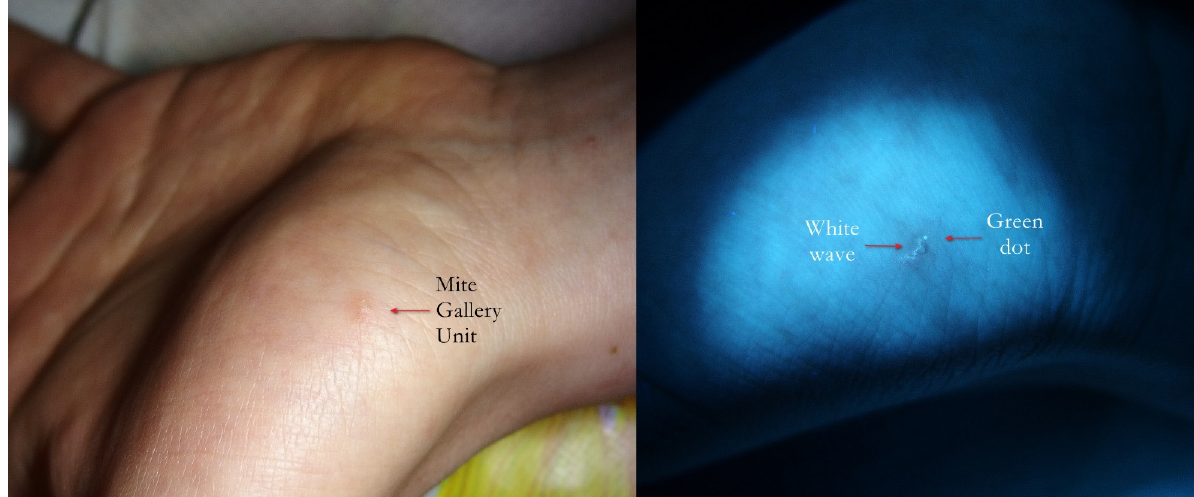
Figure 11. Flash light vs. UVA. On thenar eminence, a very suggestive linear lesion ( left ) that under UVA ( right ) clearly became a wavy gallery (white wave) ending with a green dot where the mite was physically located.